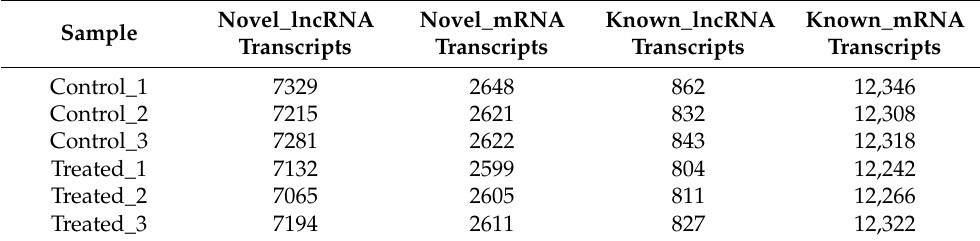
Table 3. Statistics of all expressed transcripts from the six genome